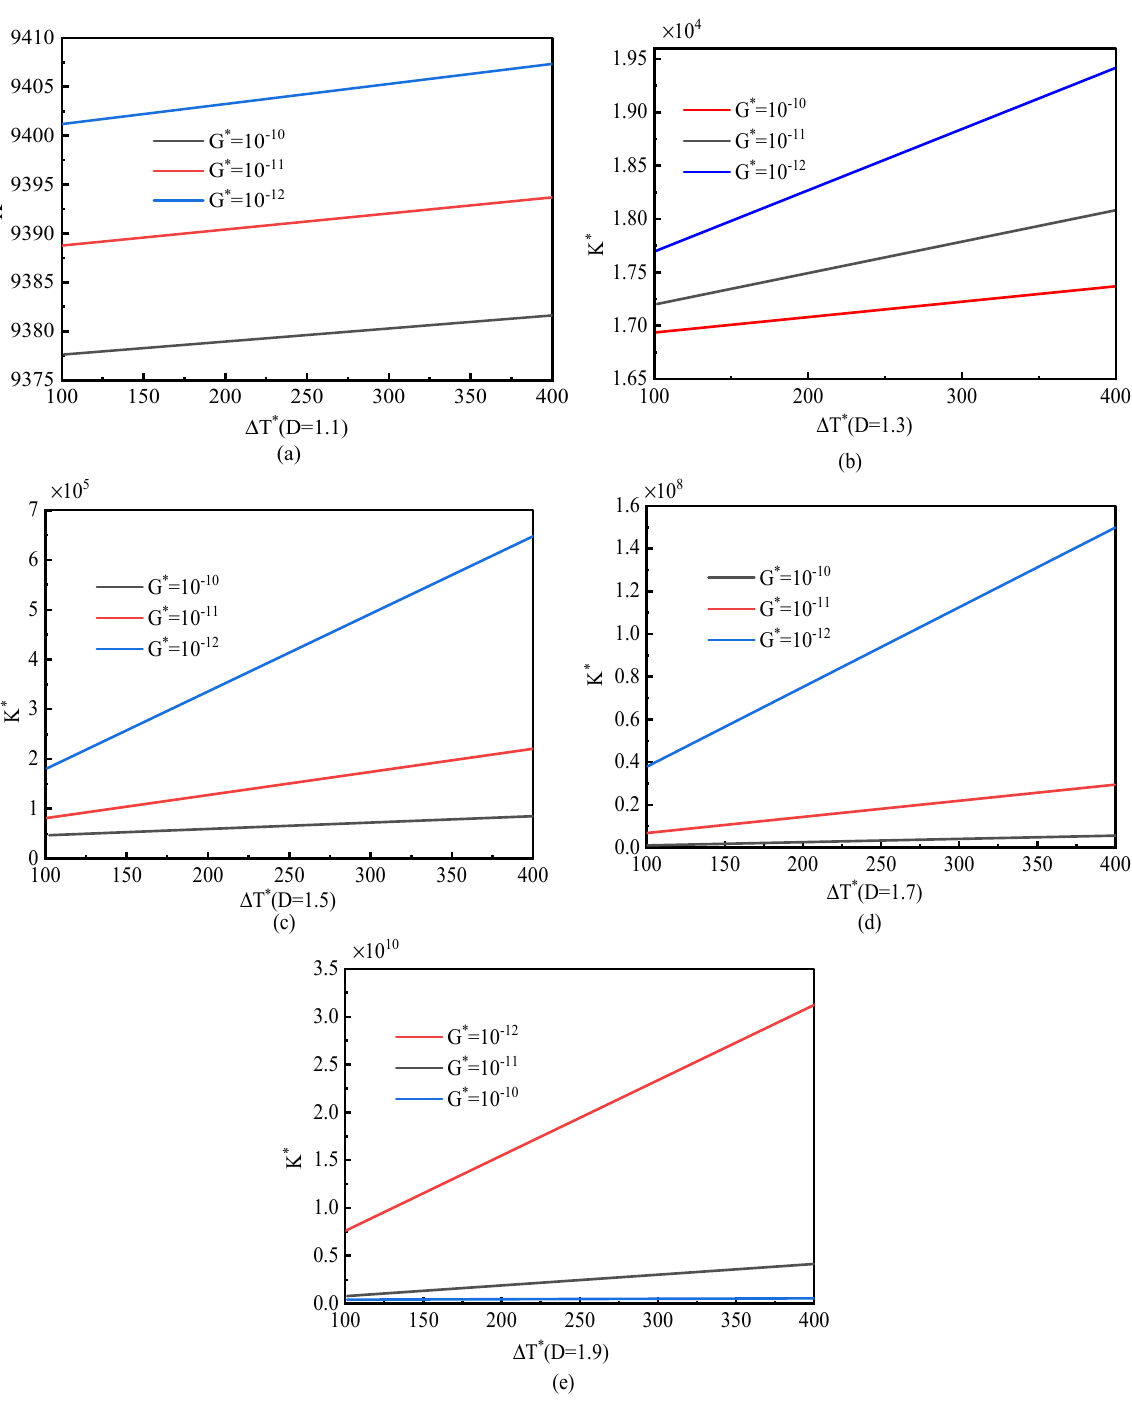
Figure 4. Influence of length scale parameter G* on ∆ T ∗ -K* curve; ( a ) D = 1.1 ( b ) D = 1.3 ( c ) D = 1.5 ( d ) D = 1.7 ( e ) D = 1.9.